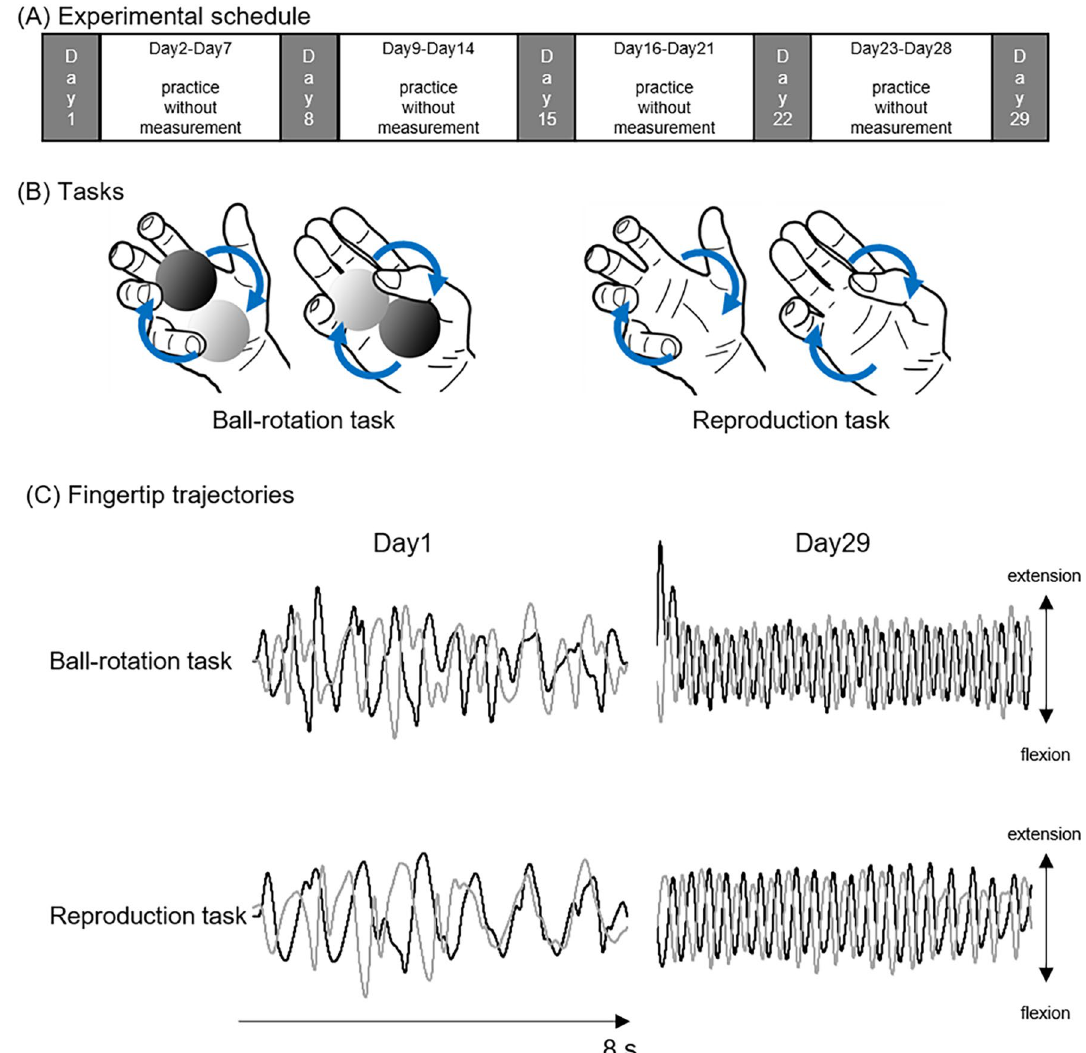
a ball rotation task and a reproduction task were conducted. ( B ) Motor tasks: the ball-rotation task and the reproduction task. In the ball-rotation task, the participants were asked to rotate two balls around each other in a clockwise direction as quickly as possible. In the reproduction task, the participants were asked to reproduce the movement of the ball rotation as accurately as possible. ( C ) Typical waveforms of thumb and index finger tips in an 8-s trial from one participant on day 1 and day 29. Black lines indicate thumb and grey lines indicate index finger. Waveforms of the other three digits (middle, ring, and little fingers) are not shown in this figure because of